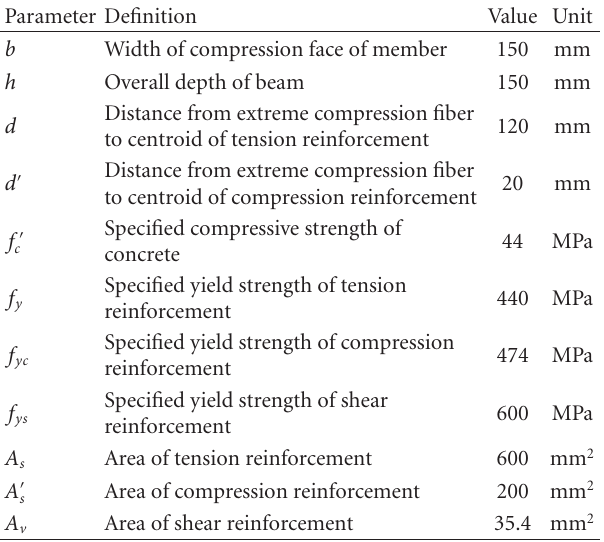
Table 1: Properties of RC